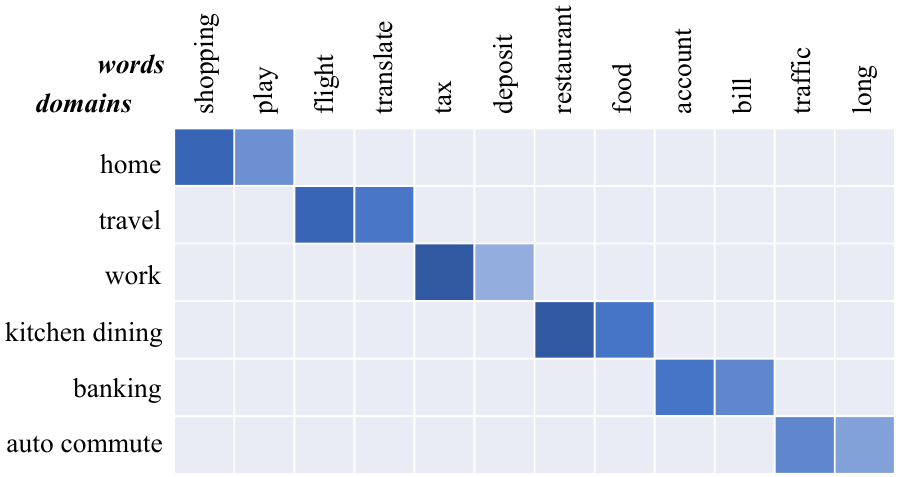
Figure 1. Word importance estimation on multi-domain data (Clinc150 [12]) using word frequency [13]. We list the top two words for each domain. The darker the color, the more important the